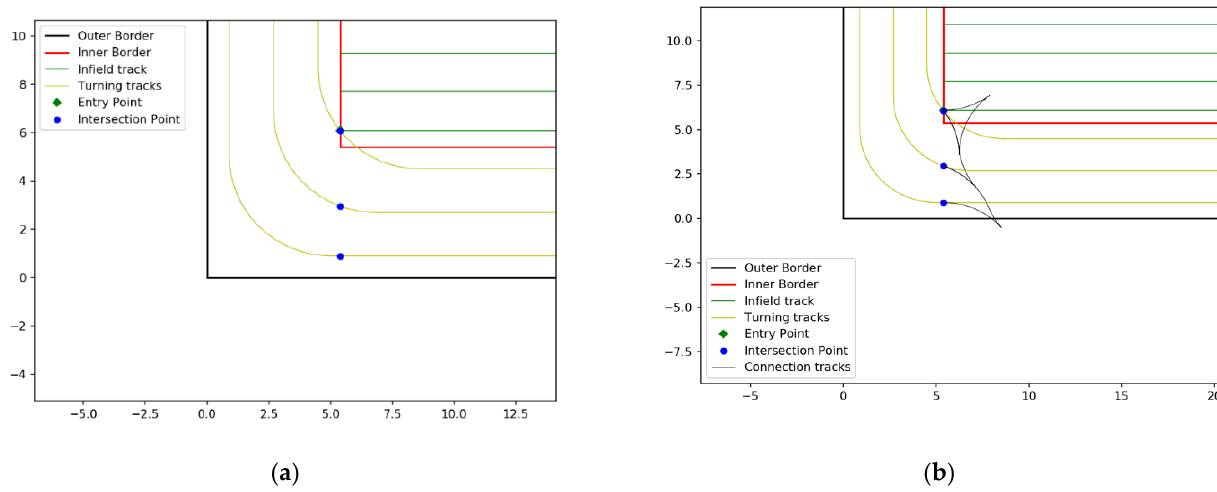
Figure 11. (a) Entry points and (b) connection paths between each headland pass. 261 The headland tracks start at the intersection point of the first headland pass. After 262 completing the first headland pass, the tractor moves from the intersection point of the 263 first headland pass to that of the second headland pass. The same pattern is repeated until 264 all the headland passes are covered. The tractor then travels from the intersection point of 265 the last headland pass to the entry point of the first infield track. 266